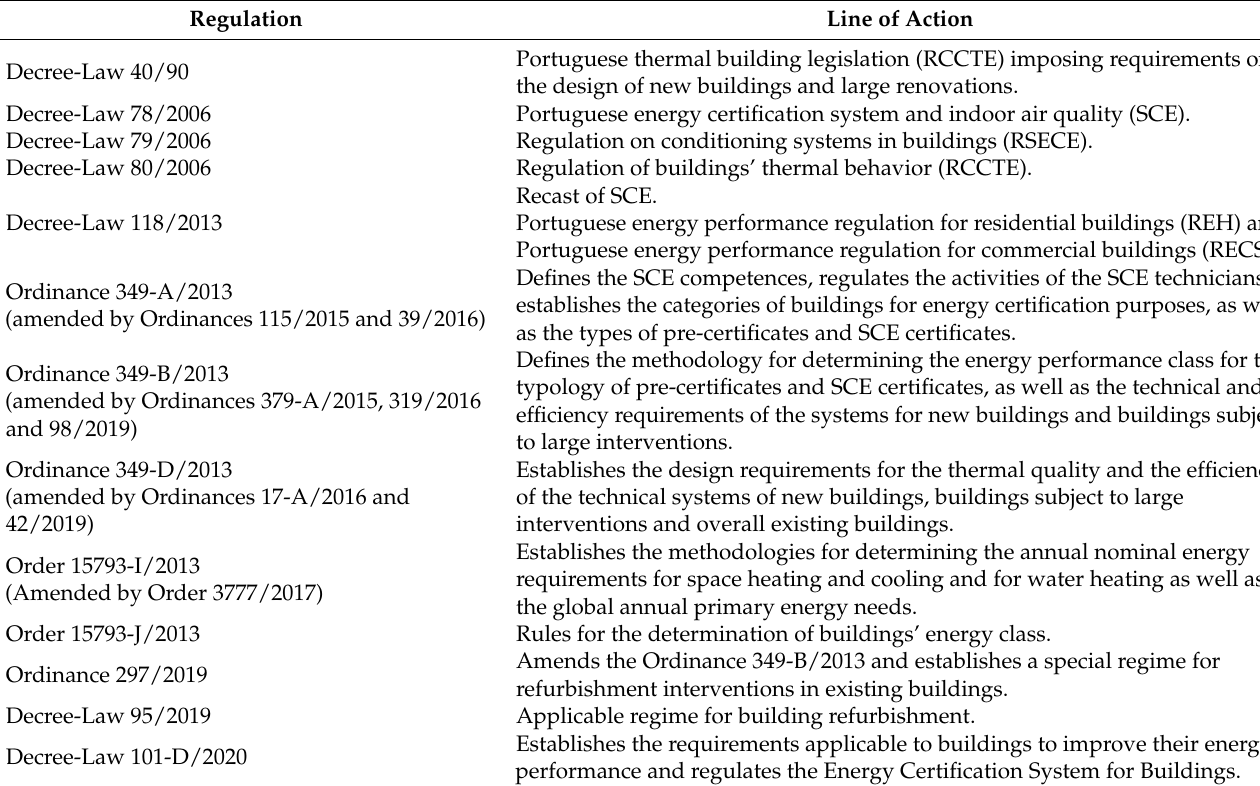
Table A1. Portuguese legislation on thermal and energy performance of buildings (non-exhaustive